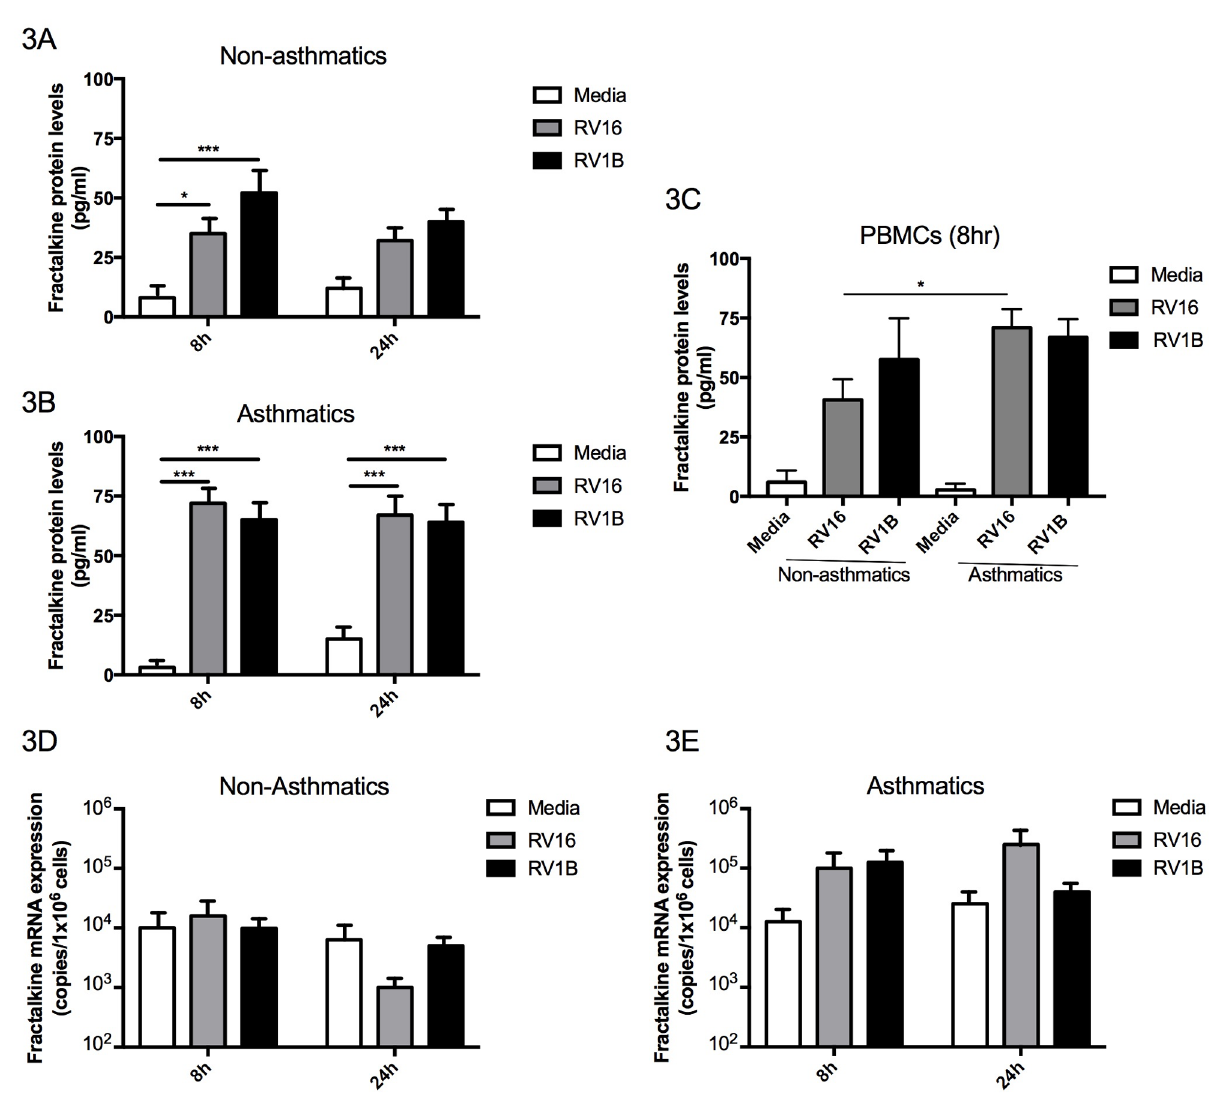
Fig 3. Change in levels of fractalkine in PBMCs following in vitro infection with RV16 and RV1B. Solublefractalkineprotein was measuredin cell supernatantsfrom PBMCs obtainedfrom (A) non-asthmatic (n = 15) and (B) asthmatic (n = 15) subjects and compared betweensubject groups at 8hrs post infection (C). FractalkinemRNA expressionwas measuredin PBMC cell lysate cDNA obtainedfrom (D) non-asthmatic and (E) asthmatic subjects. The results are expressedas mean ± SEM. Protein data were analysedby one-wayANOVA with Bonferroni post-test and mRNA by Kruskal Wallis with Dunn’spost test ( * P < 0.05, *** P < 0.001).